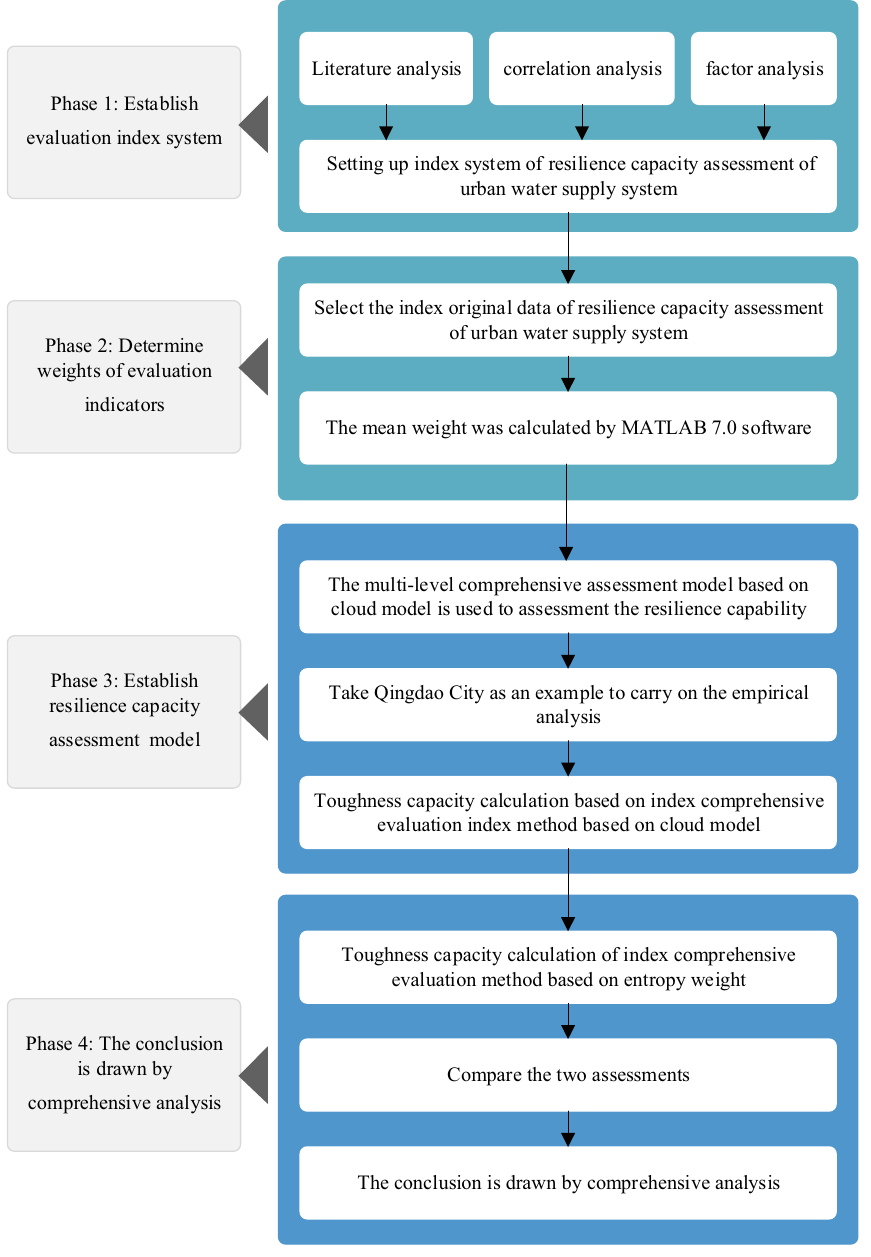
Figure 4. Research framework (from top to bottom, the figure shows the logical process and methods of toughness evaluation of urban water supply system in four